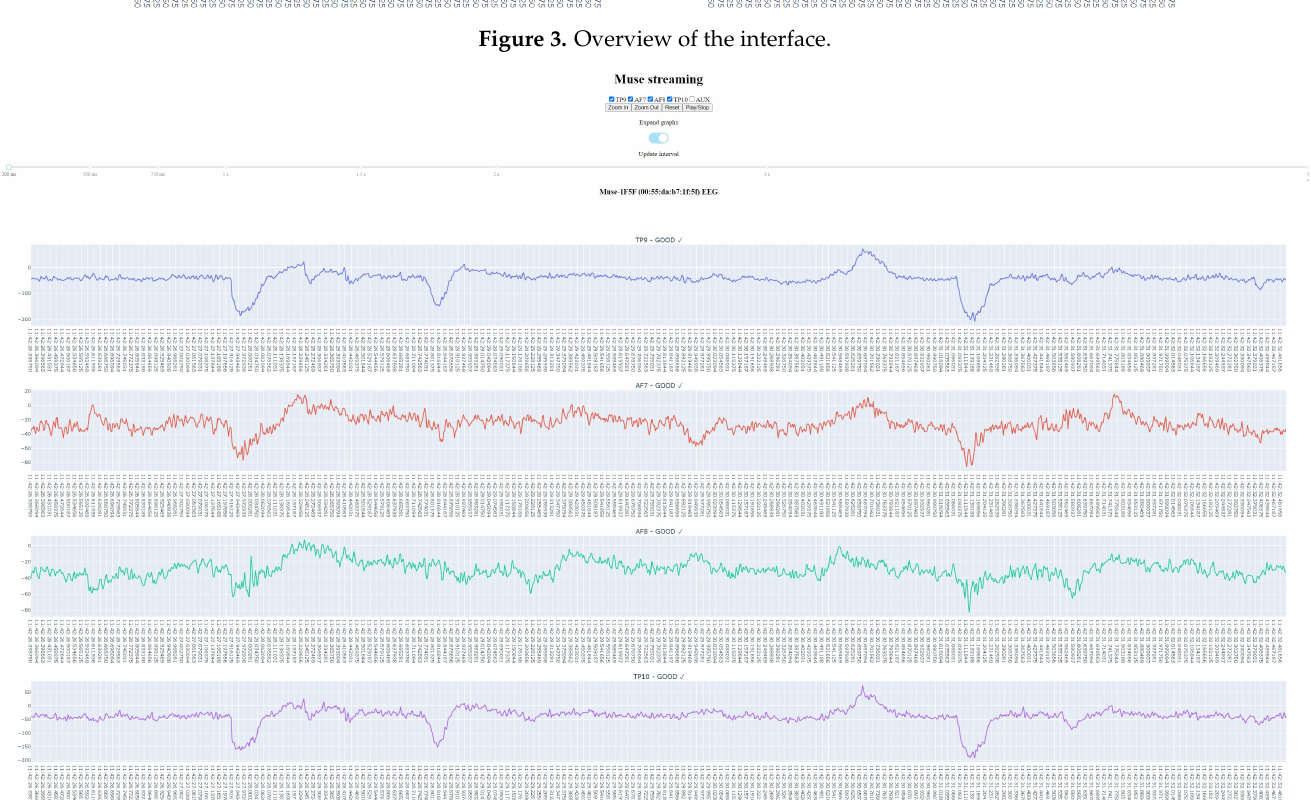
Figure 4. Expanded view of the